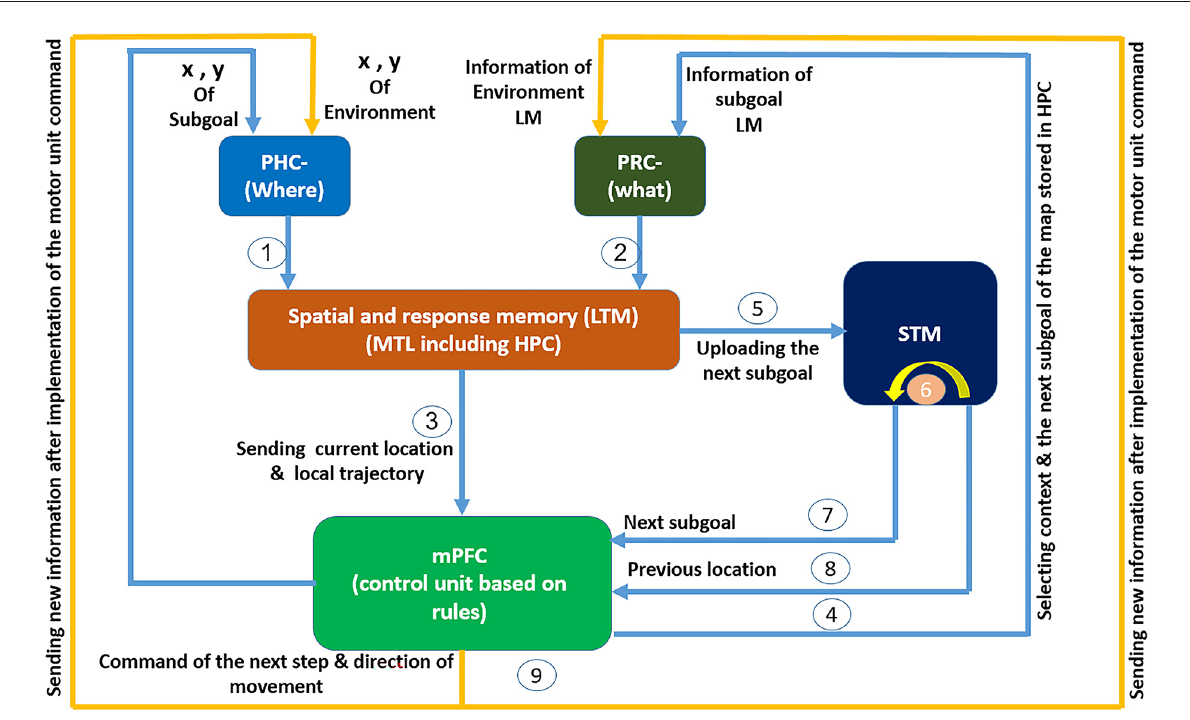
FIGURE1 The cognitive model of navigation focused on mPFC role in spatial memory retrieval control: spatial information regarding the agent’s location and the nature and location of objects arrives at the PHC and PRC through the what and where streams. After preliminary processing, the information reaches the spatial and response memory structures through information pathways 1 and 2. These structures are where place cells, grid cells, and head direction cells reside. subsequently and after integration and processing of spatial information in this region, information regarding the agent’s current place and the local trajectory enters the PFC through path number 3, where the PFC acts as a control unit responsible for controlling memory retrieval. In the PFC, spatial information is matched against the rules sets that have been formed in mPFC during learning. Then, based on the input information, the context and address code for the next expected landmark are fed back by the mPFC to the HPC where the cognitive map is stored, through path number 4 and the PRC. In the HPC this code is matched against the cognitive map and the next expected landmark is loaded into the memory. This loaded data is compared with the input information from the environment through the what stream. If a mismatch is observed, a “wrong path” message follows in order for the agent to correct its choice. If the environmental information matches the cognitive map, the next expected landmark information (which itself results from the control unit’s prediction and recall from the cognitive map) including its characteristics and location, as well as the agent’s current location are sent to the next subgoal buffer in the short-term memory through path number 5 and its previous stored information shifts to the previous spatial buffer through path number 6. This information is made available to the spatial working memory and the control unit through paths number 7 and 8, such that an appendage of such information to the response memories will transmit the next step command and its direction to the motor units. After that movement command has been executed, the new agent’s location and environmental landmarks enter the sensory inputs through path number 9 and this cycle continues until the goal is